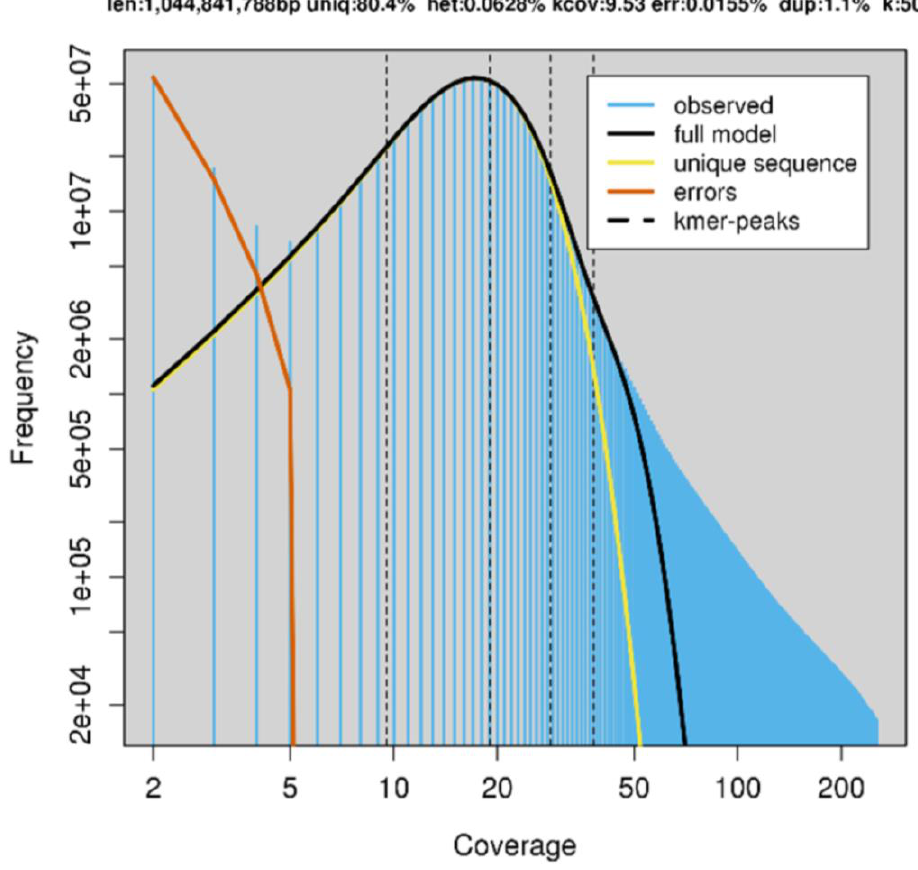
Figure 2. GenomeScope model with k-mer = 50, input forward reads trimmed with FastP to remove the adapter and poly-G sequences. Table 1. GenomeScope model kmer = 50, forward reads trimmed to remove adapter and poly- G